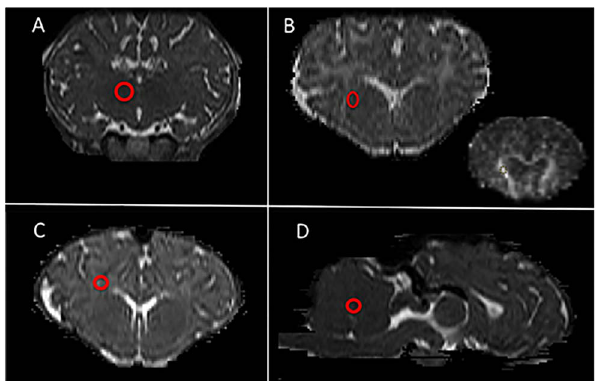
Figure 2. Regions of interest placement for DTI analyses. Representative example of ROI placements (red circles) on high- resolution T2 images (A-C, coronal orientation; D, sagittal orientation). A: thalamus, B: internal capsule (inset: corresponding MD map), C: periventricular white matter, D: cerebellar vermis